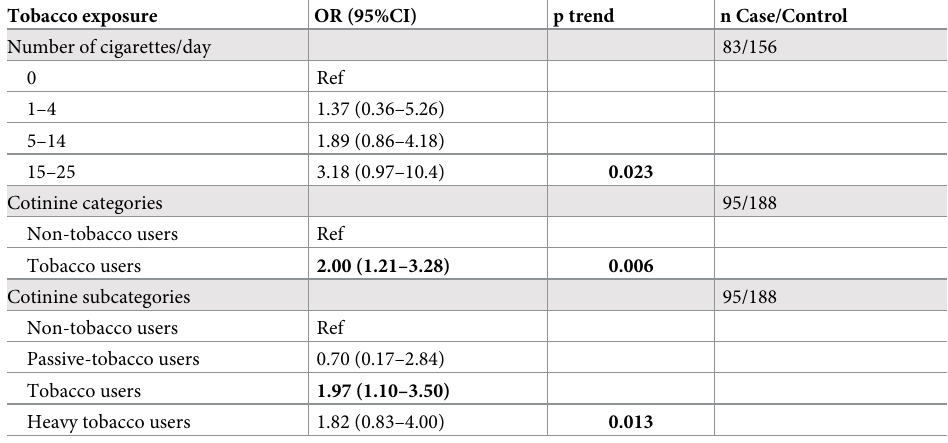
Table 2. Conditional logistic regression, univariable odds ratios (OR) and 95% confidence intervals (CI) and p for trend across categories, for developing inflammatory bowel disease and categories of tobacco exposure.